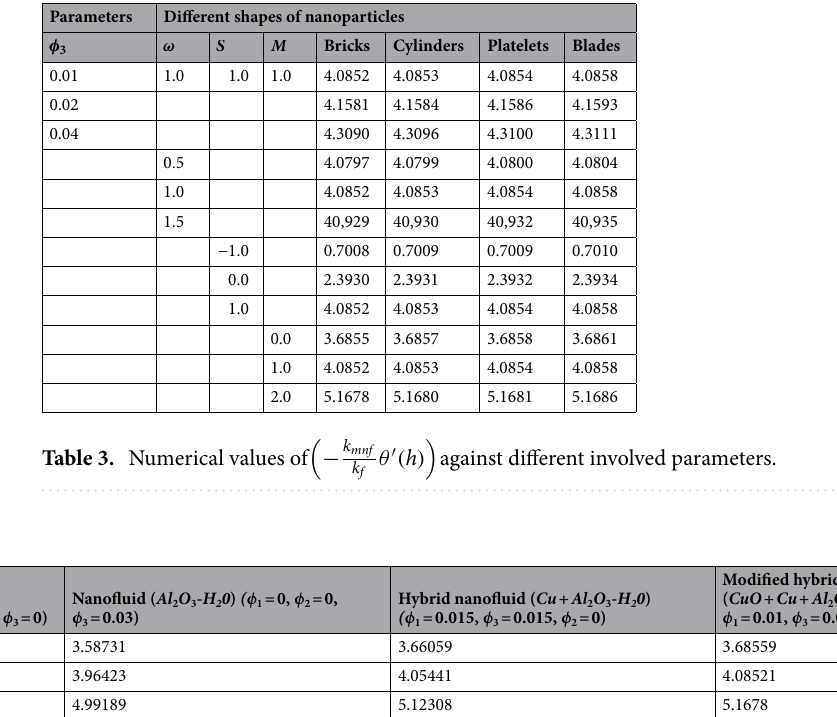
Table 4. Comparison of modified hybrid